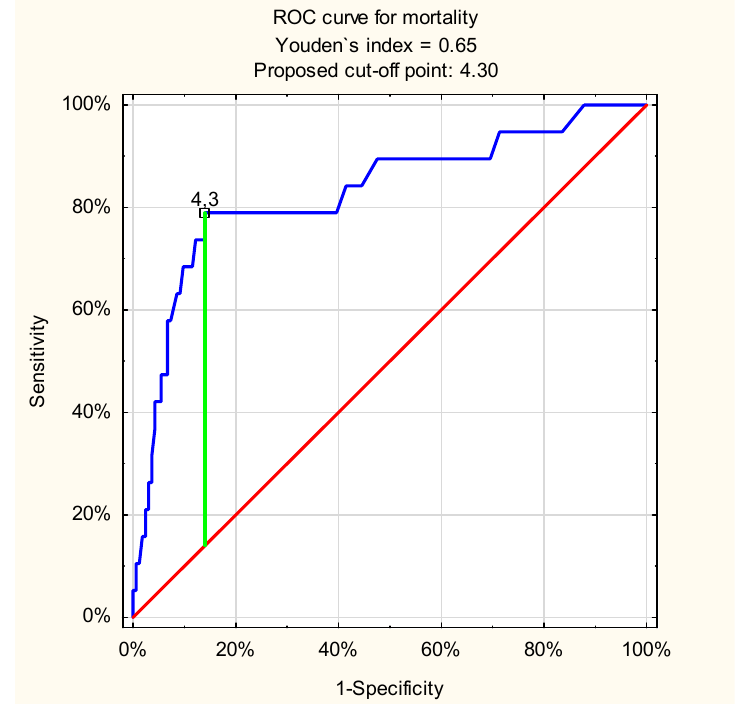
Figure 3. ROC curve for admission venous lactate level and in-hospital mortality in patients with non-variceal UGIB (proposed cut-off point = 4.3 mmol/L; sensitivity = 0.79; specificity = 0.86; accuracy = 0.85; AUC = 0.83 (95% CI: 0.72–0.94); p < 0.001).